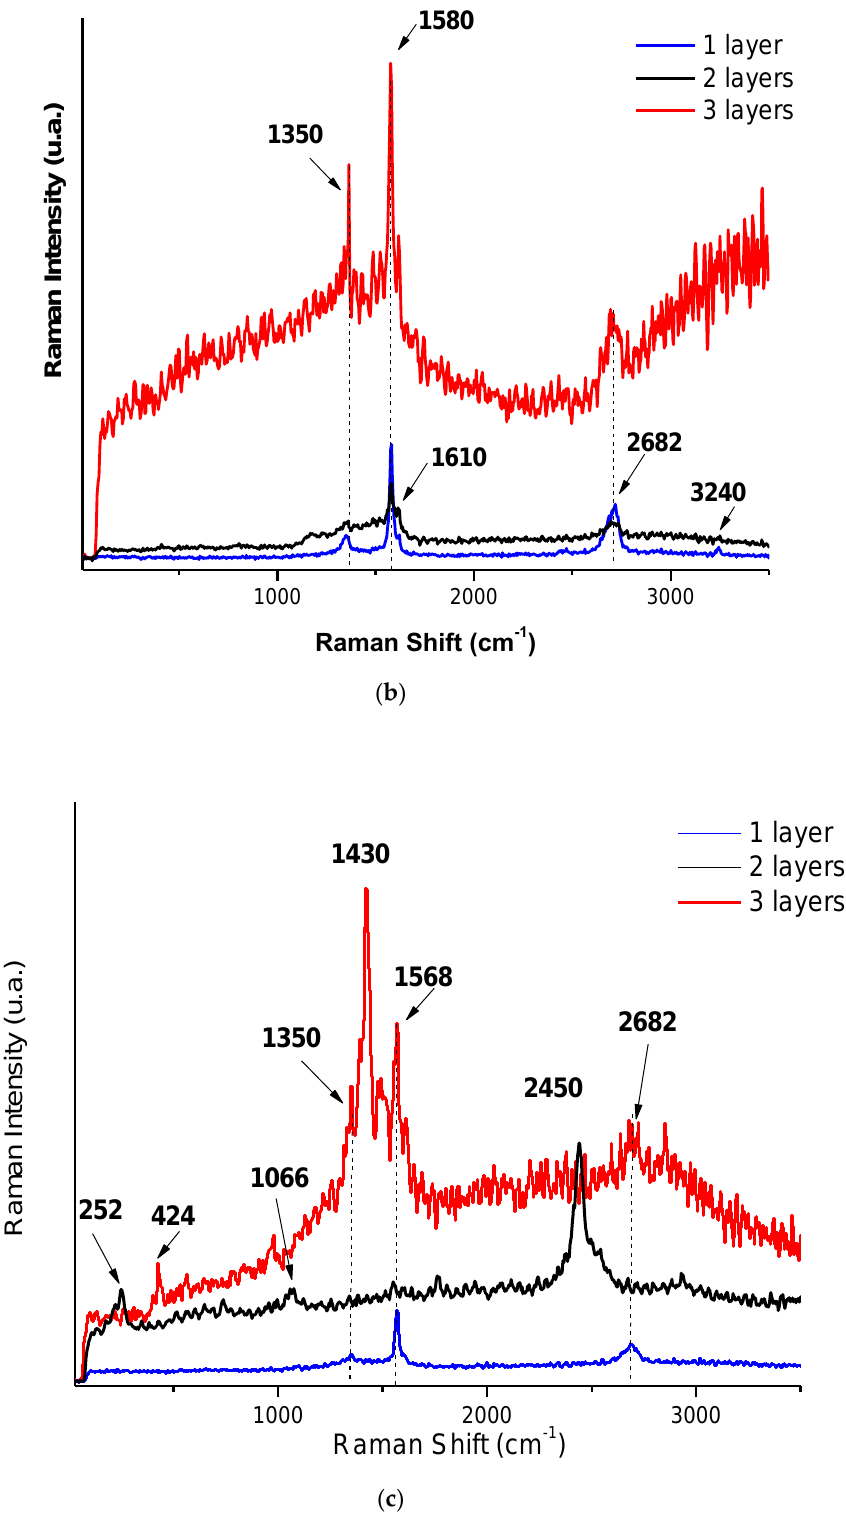
Figure 7. Raman spectra of ( a ) HCl-, ( b ) HBr-, and ( c ) PSS-doped PANI/graphene/PEDOT:PSS water-based formulations with one, two, and three layers.